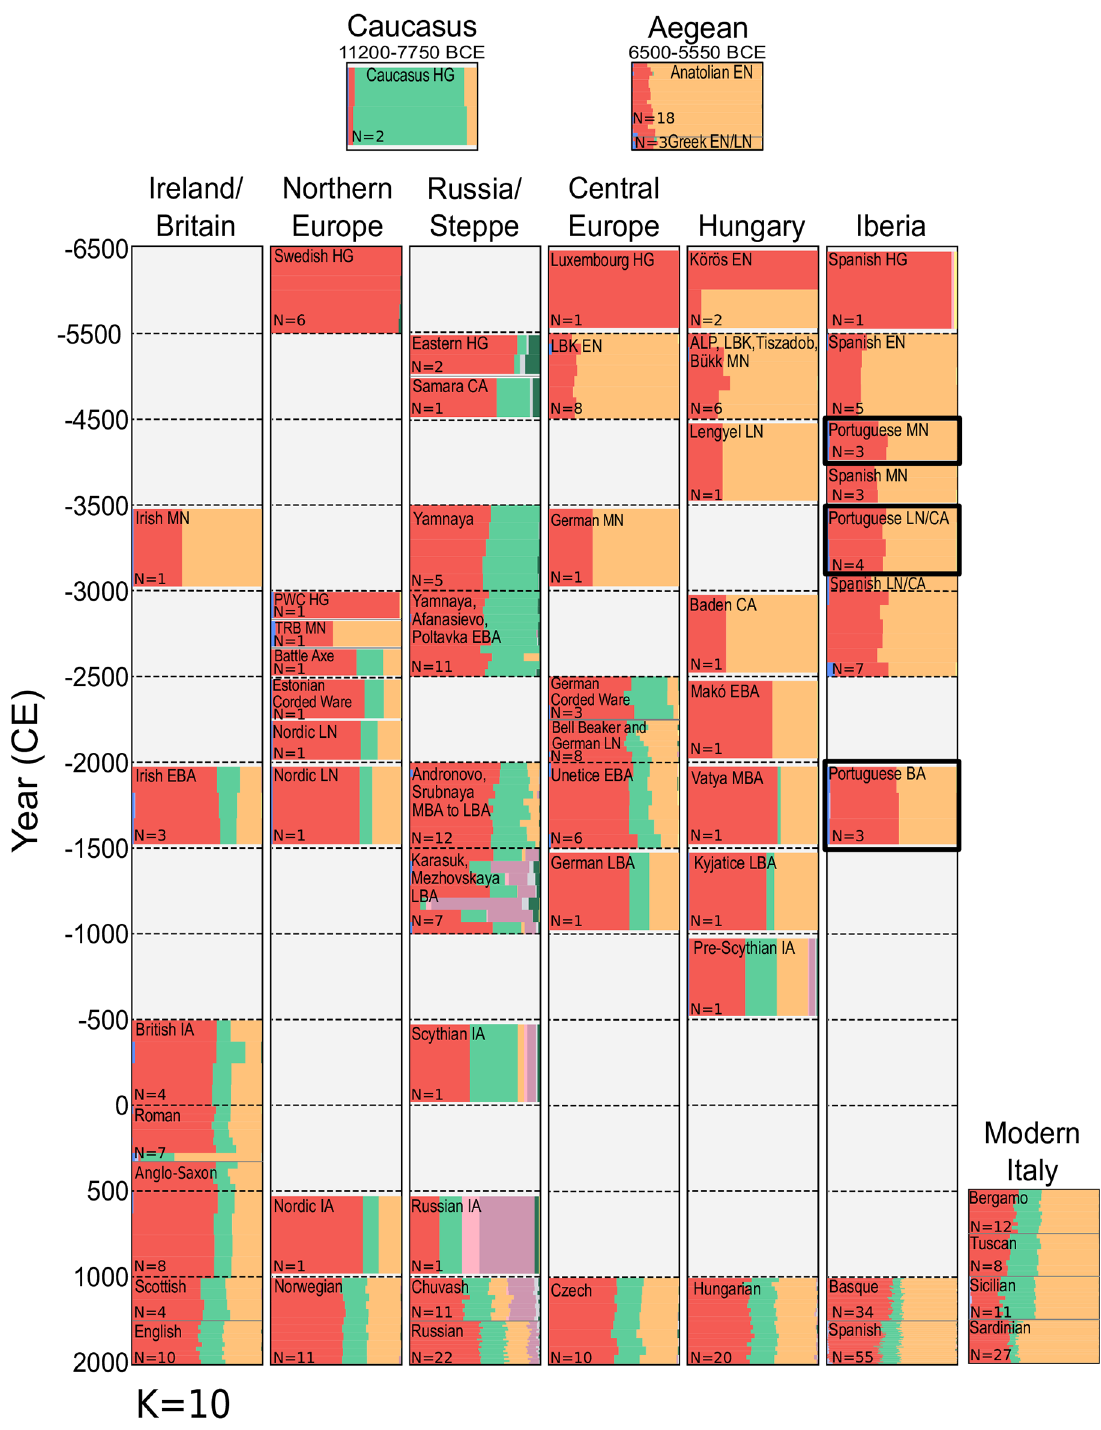
Fig 4. ADMIXTURE analysis of 1941modern and 176 ancient individuals. Selected profiles of 227 ancient samples, alongside individuals from nine present-day Eurasian populations are displayed here for K = 10 ancestral clusters. Individualsare orderedwithin a grid, partitionedby approximate time periodand geographicregion. Where possible, ancient individualshave been groupedunder common population labels, basedon archaeologicalcontext. For populationscontaining three or less individuals, bar plots have been narrowed,leavingempty space within the grid box. Samplesfrom the current study are highlighted in bold.